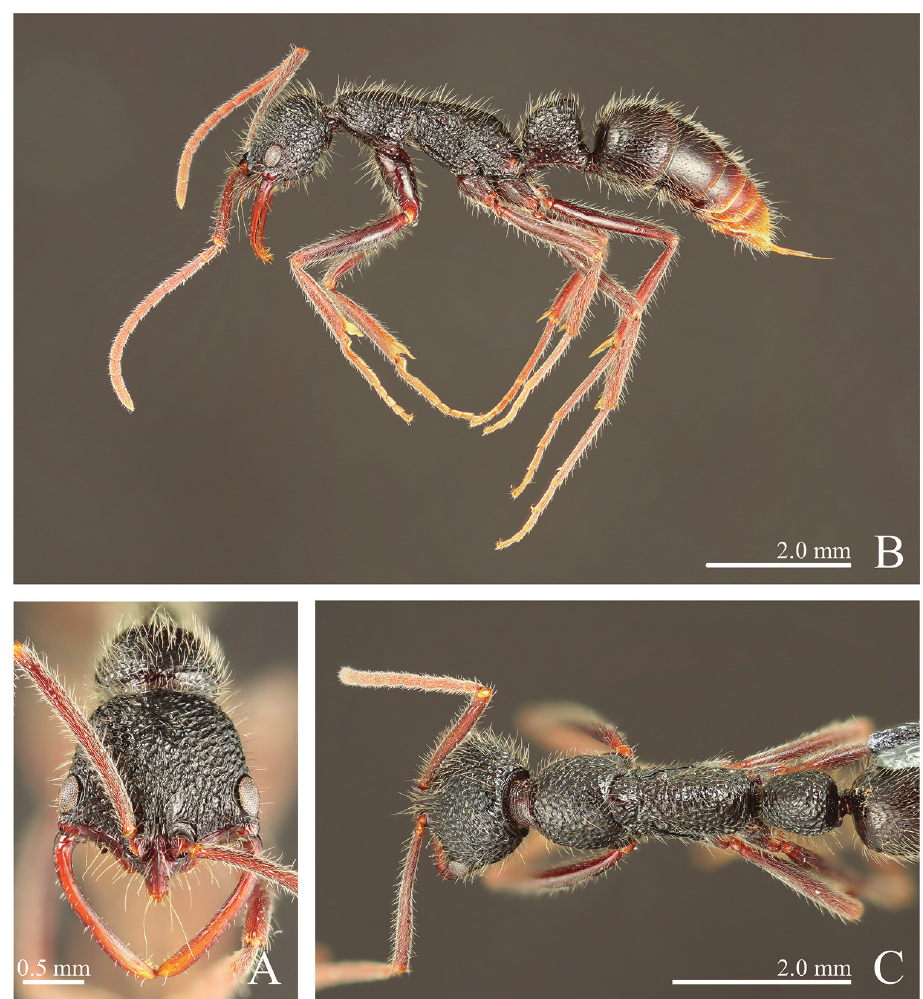
Figure 8. Leptogenys itoi sp. n., holotype, worker. A head, full-face view B lateral view, C dorsal view. Fuminori Itô leg. [BLKU]; 1 worker (FI92MG-270-7), same place, VII-X 1992, Fuminori Itô leg. [BLKU]; 2 workers, 1 queen (FI92MG-366), same place, VII-X 1992, Fuminori Itô leg. [1 worker, 1 queen: BLKU; 1 worker: SKYC]; 6 workers (FI92MG-456), 2 workers (FI92MG-463), same place, VII-X 1992, Fuminori Itô leg. [BLKU]; 4 workers (FI92MG-518), same place, VII-X 1992, Fuminori Itô leg. [3 worker: BLKU; 1 worker: SKYC]; 4 workers, 1 male (BG99-2), same place, V 1999, Bruno Gobin leg. [BLKU]; 4 workers (FI04-119), same place, 19 XII 2004, Fuminori Itô leg. [BLKU]; 6 workers, 1 queen, 1 male (FI04-120), same place, 17 XII 2004, Fuminori Itô leg. [BLKU]; 8 workers, 1 queen (AG05-20), same place, VII 2005, Ayako Gotô leg. [BLKU]; 1 worker, same place, 3 XII 2005, Seiki Yamane